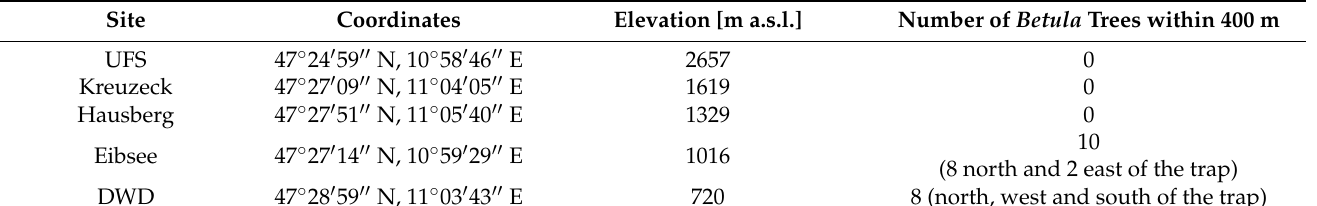
Figure 1. ( a ) Study area located in southern Germany (GeoBasis-DE/BKG 2018) and ( b ) locations of the gravimetric pollen traps (red dots) and locations of the examined birch trees (white circles; numbers indicate the amount of birch trees at this location when there was more than one). The line represents the border between Germany and Austria. Land cover: © European Union, Copernicus Land Monitoring Service 2018, European Environment Agency (EEA); Hillshade: EuroGraphics. Table 1. Characteristics of the locations of gravimetric pollen traps.